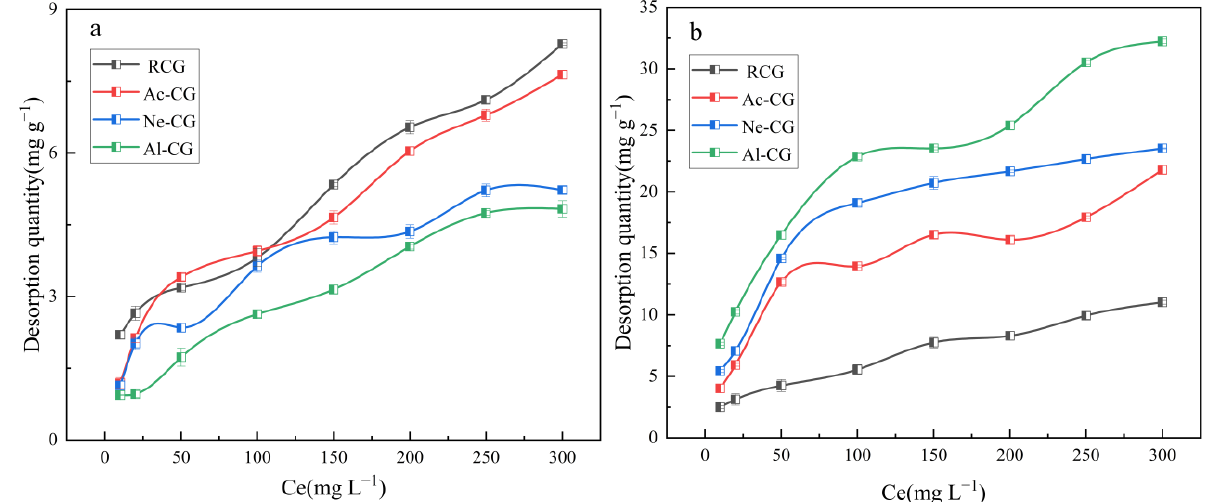
Figure 4. Desorption curves of coal gangue samples toward phosphate for 10h; the desorbents are distilled water ( a ) and NaHCO 3 solution ( b ), respectively, and the coal gangue samples are those that have absorbed phosphate in the adsorption isotherms experiment. Error bars represent standard error of the mean ( n = 3).